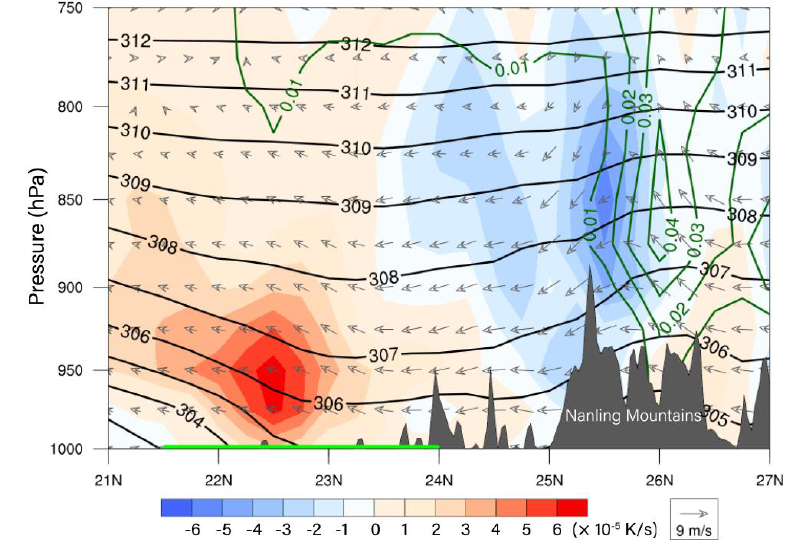
Figure 9. Vertical cross-section along the thick purple line in Figure 8a for the PRD-only heatwave days with a TC centered in Region A. Arrows denote the wind vectors along the plane. The vertical velocity is multiplied by a factor of 200. Black contours denote the potential temperature (θ; unit: K). Green contours denote the mixing ratio of cloud liquid water (q c ; unit: g kg −1 ). Shadings denote the horizontal advection of θ. Gray shading denotes topography. Thick green line indicates the location of the PRD region.